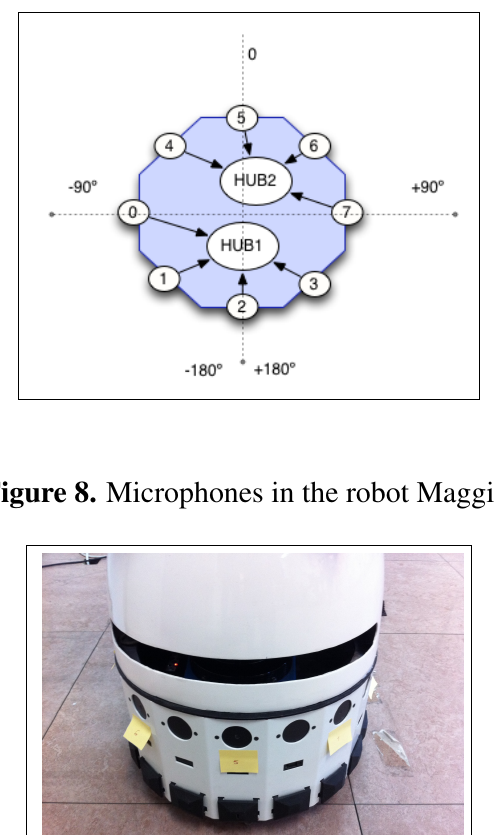
Figure 7. Microphone layout in the robot Maggie.